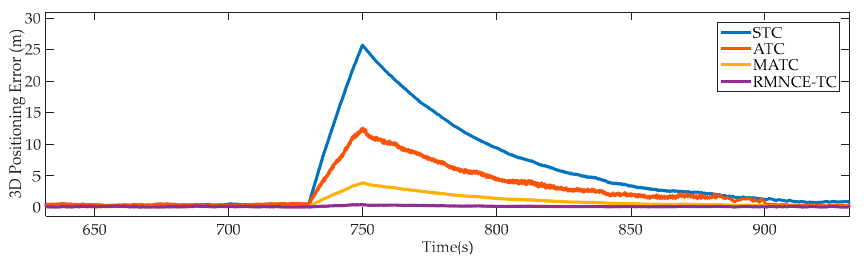
Figure 6. 3D positioning errors of the selected schemes during [730 s, 750 s]. Table 4. Satellite selection results of the different schemes at the 740-th second.